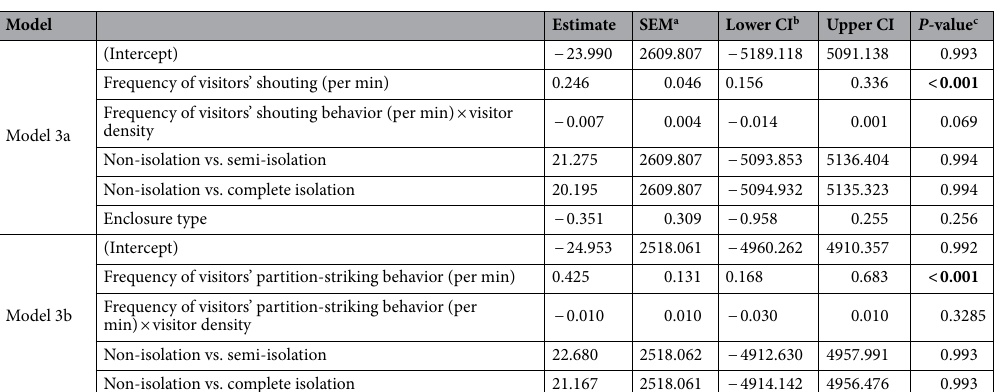
Table 5. Effect of visitor behavior intensity (shouting) on the visitor-directed vigilance of gibbons (model 3a) and Effect of visitor behavior intensity (striking the glass partition) on the visitor-directed vigilance of gibbons (model 3b). *Visitor density (original mean ± SD = 5.53 ± 7.85); the reference level of the isolation phase is “non-isolation.” a SEM standard error of the mean. b CI confidence interval. c P -values in bold are